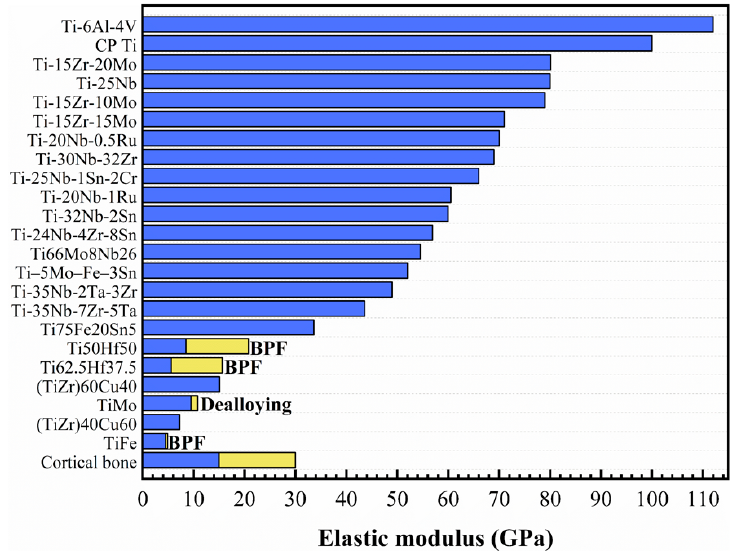
Figure 2. The elastic modulus of different composition and modified β -Ti alloys (BPF -impregnated by bisphenol F epoxy resin). Reprinted with permission from ref. [40,44–50]. Copyright Elsevier, 2018, 2019, 2020, and 2021.